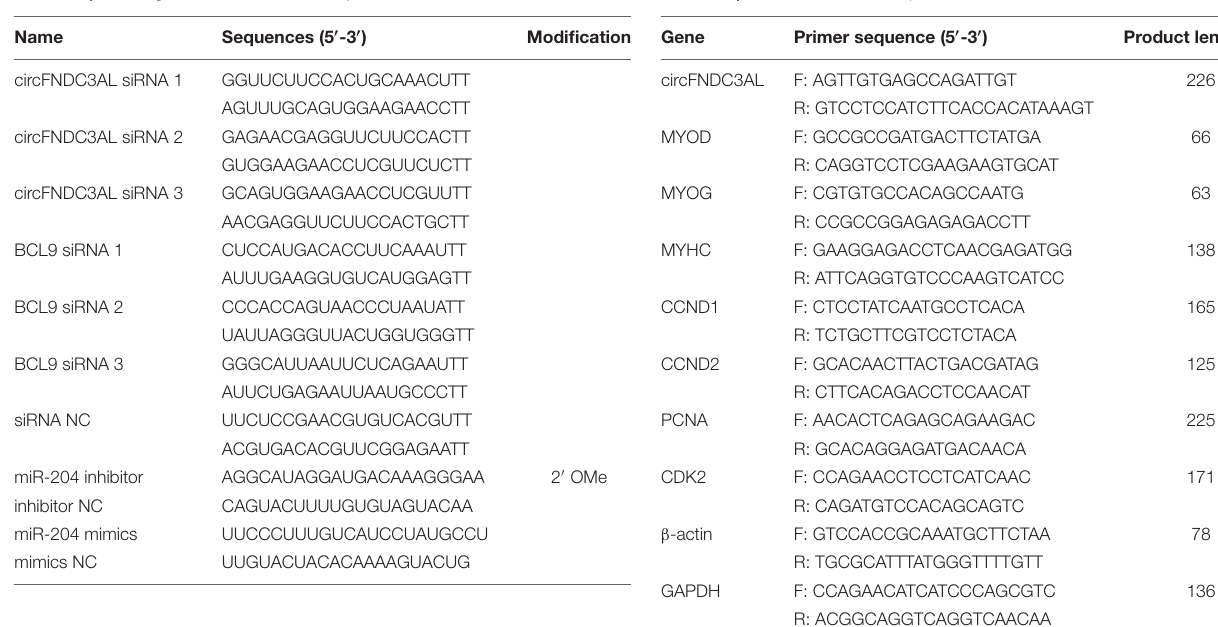
TABLE 2 | Primers used for the